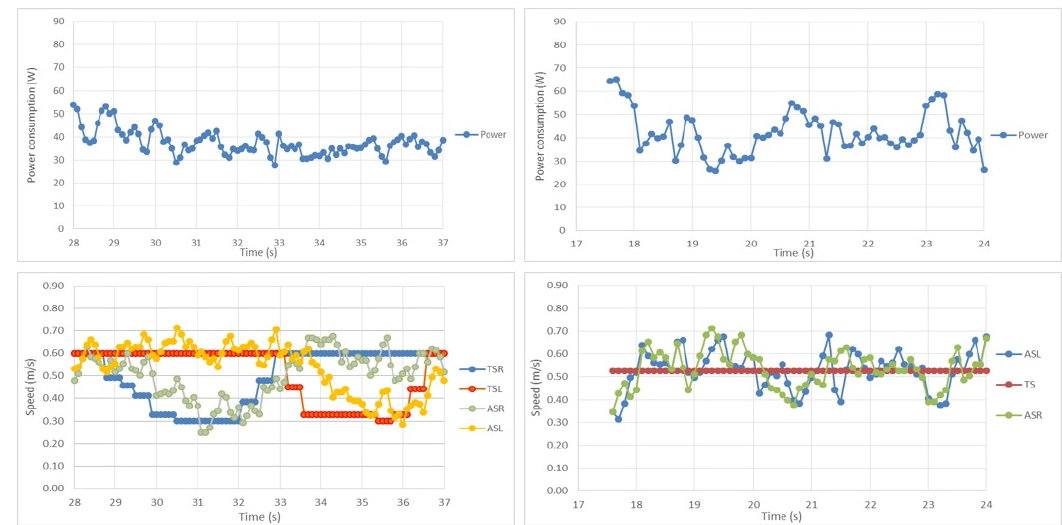
Figure 13. Detailed recordings of the dynamic behavior of the robotic vehicle, from the low-level control unit perspective, on comparatively rough terrains and loaded in two cases: turning ( left part) and moving straight ( right part).